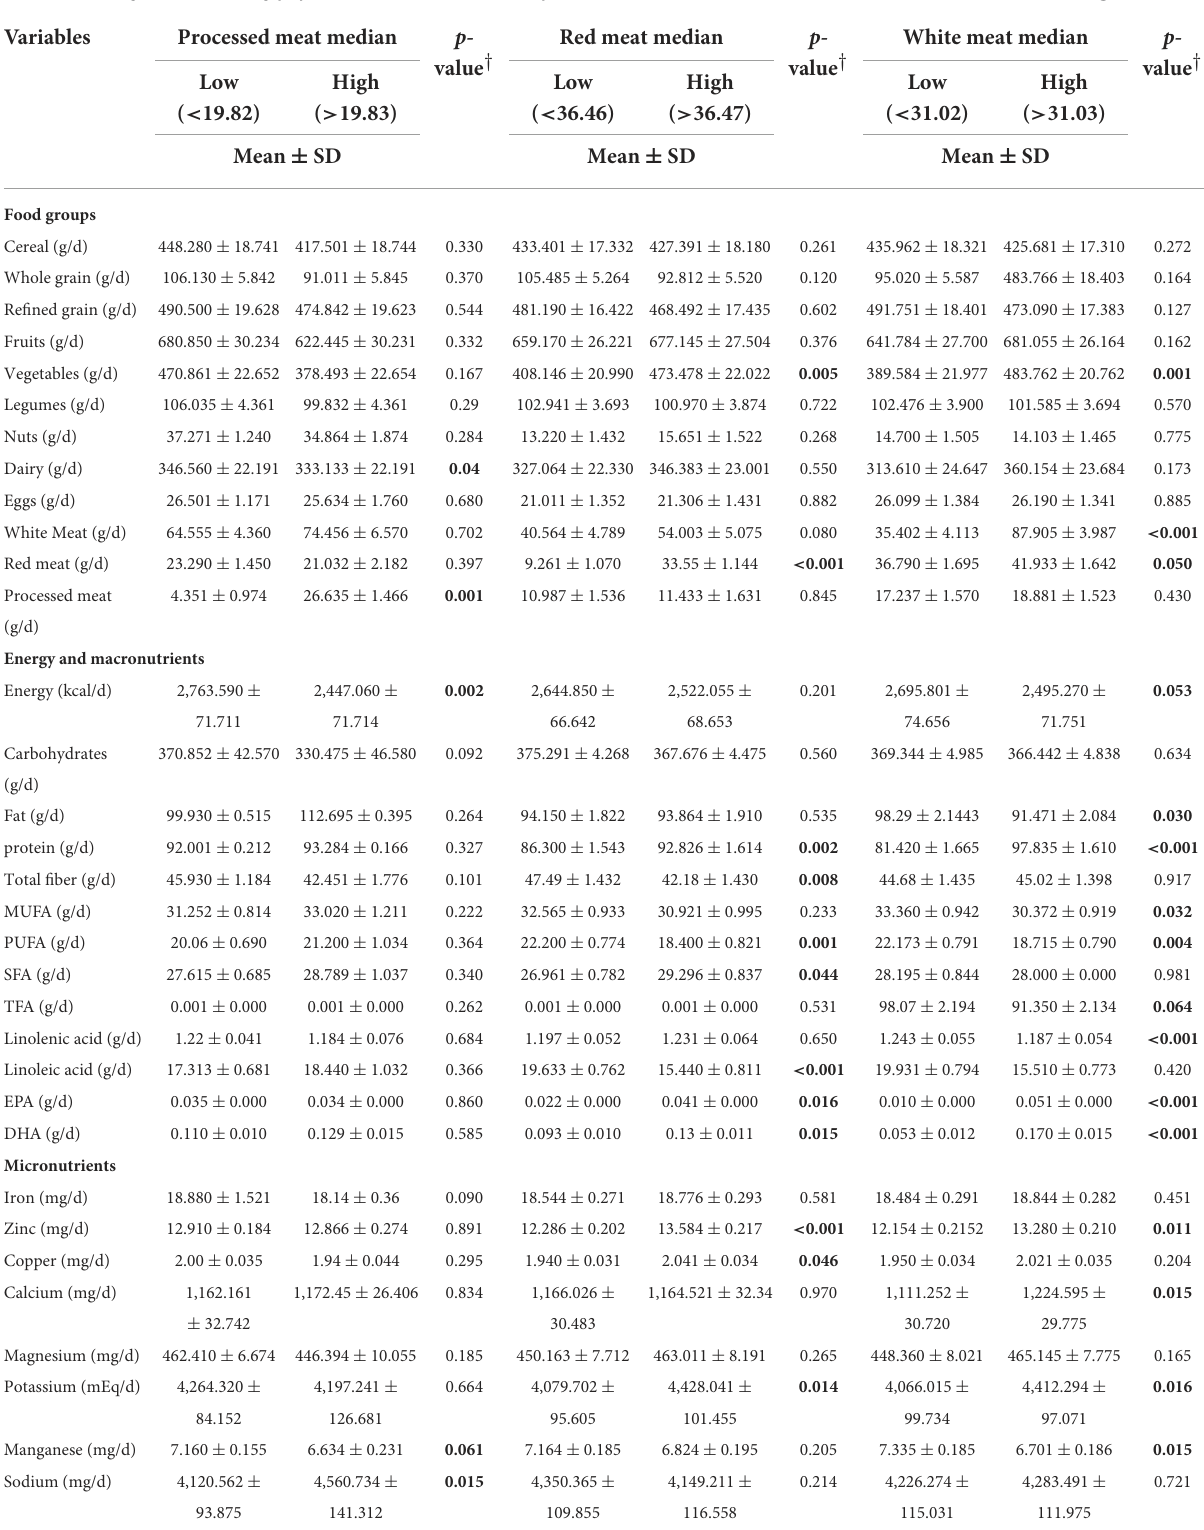
TABLE 2 Dietary intakes of study population between medians of processed meat, red meat, and white meat in 391 obese and overweight women.